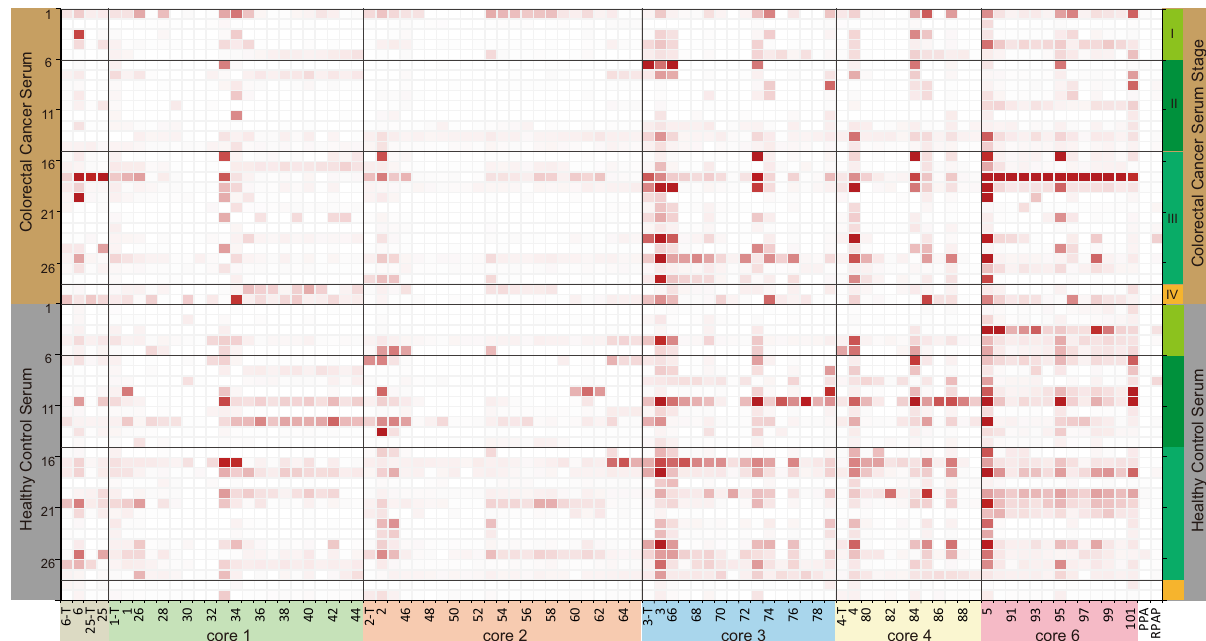
Fig. 7 Heatmap of lgM bindings on the O-GalNAc glycan microarray in sera from colorectal cancer patients and healthy control people. PPA = APGS (GalNAc α -)TAPP (100 µ M); RPAP = TSAPD(GalNAc α -)TRPAP (100 µ M); x-T, Thr-linked counterparts of Ser-linked O-glycans; Biotin = biotinylated PEG amine (0.01 mg/mL); NC = printing buffer negative control. n = 3 independent replicates. Data are presented as mean values. Source data are provided as a Source Data fi